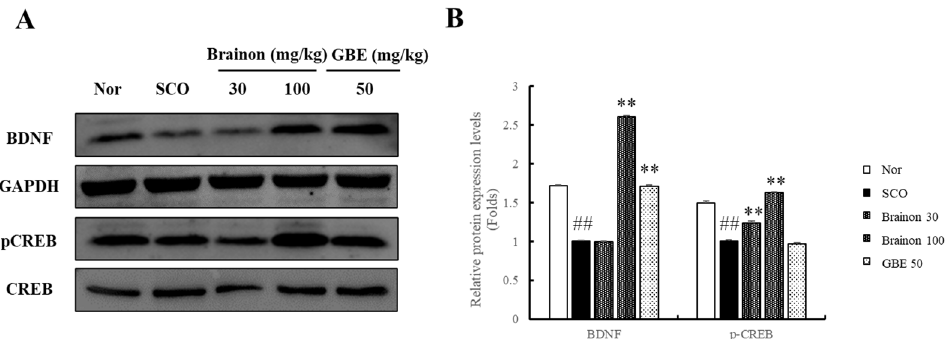
Figure 5. Effects of Brainon on CREB-BDNF pathway in the memory deficit mice hippocampal tissues. ( A ) Brain-derived neurotrophic factor (BDNF) and phosphorylation of cAMP-response element-binding protein (CREB) was measured via western blotting. ( B ) The protein band density was determined using the software. Phosphorylation levels of the CREB protein were normalized using the CREB, and BDNF protein was normalized using the GAPDH. Values are expressed as means ± SEM ( n = 3). ## p < 0.01 vs. Normal group; ** p < 0.01 vs. SCO-treated group.